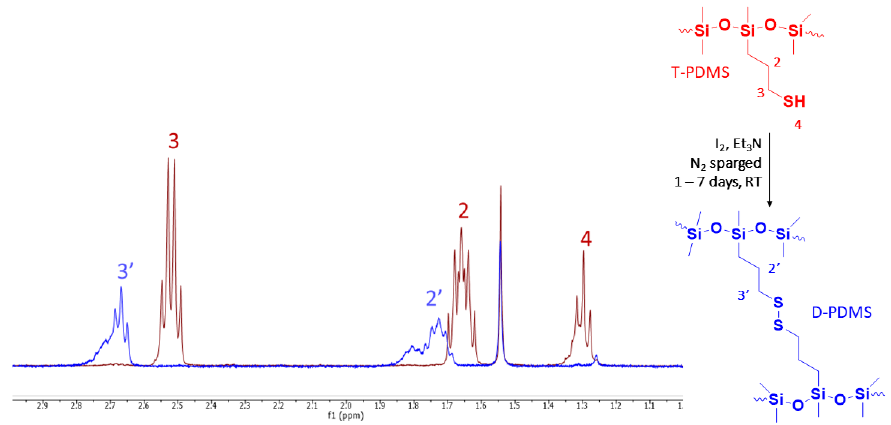
Figure 2. 1 H NMR spectra of 4 – 6% T-PDMS (red) and 4 – 6% D-PDMS 2wt% (blue).